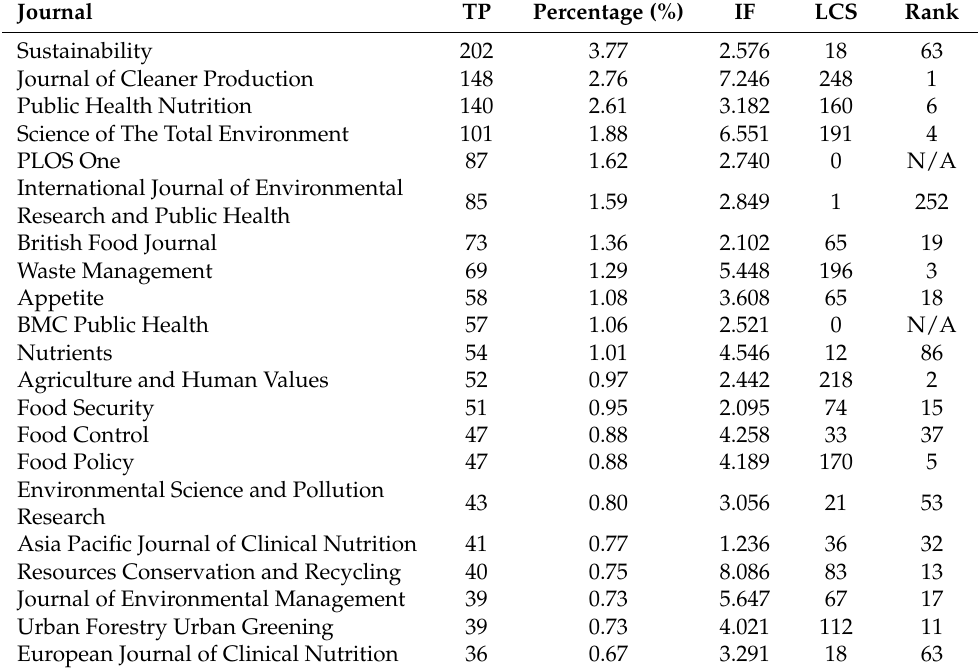
Table 2. Top 20 productive journals during